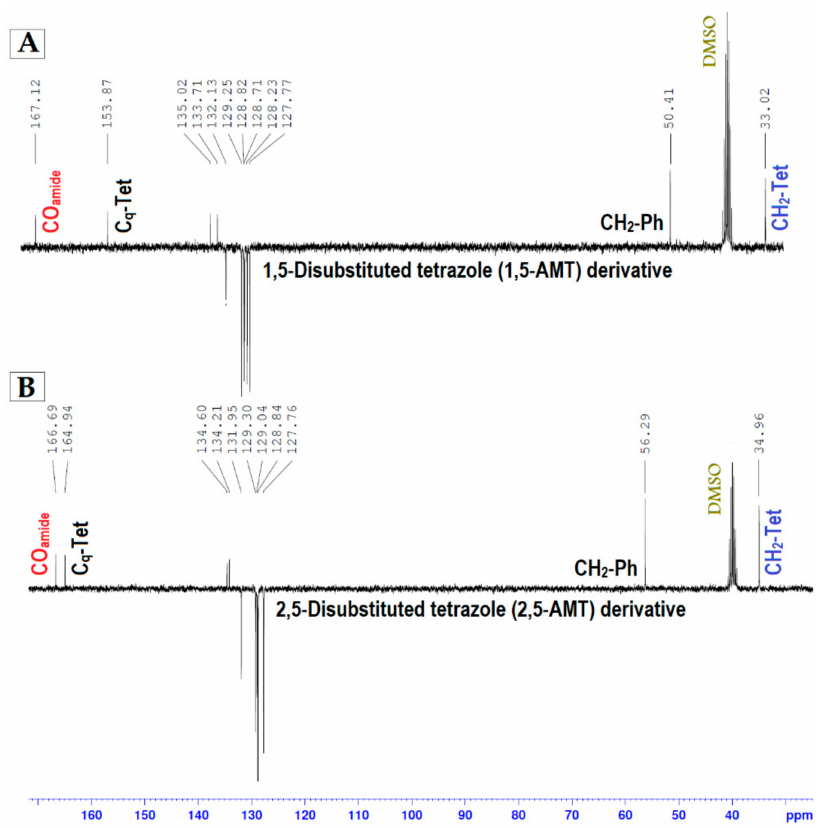
Figure 3. 13 C NMR spectra, ( A ) of 1,5-AMT and ( B ) of 2,5-AMT.